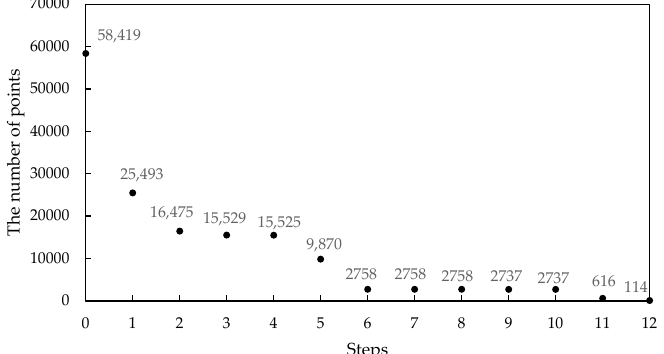
Figure 3. The number of ATL08 points remaining after each data filtering step.